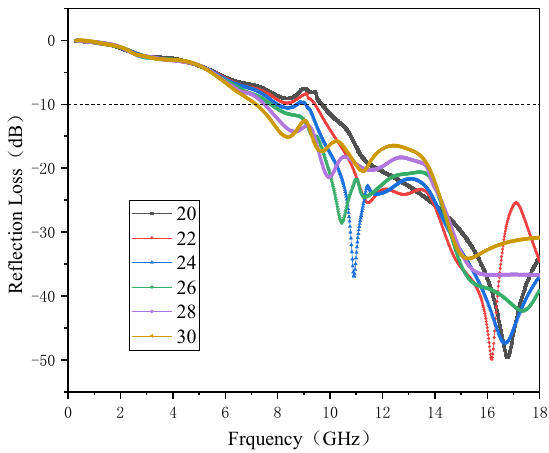
Figure 16. RL spectra of pyramid models with different angles.